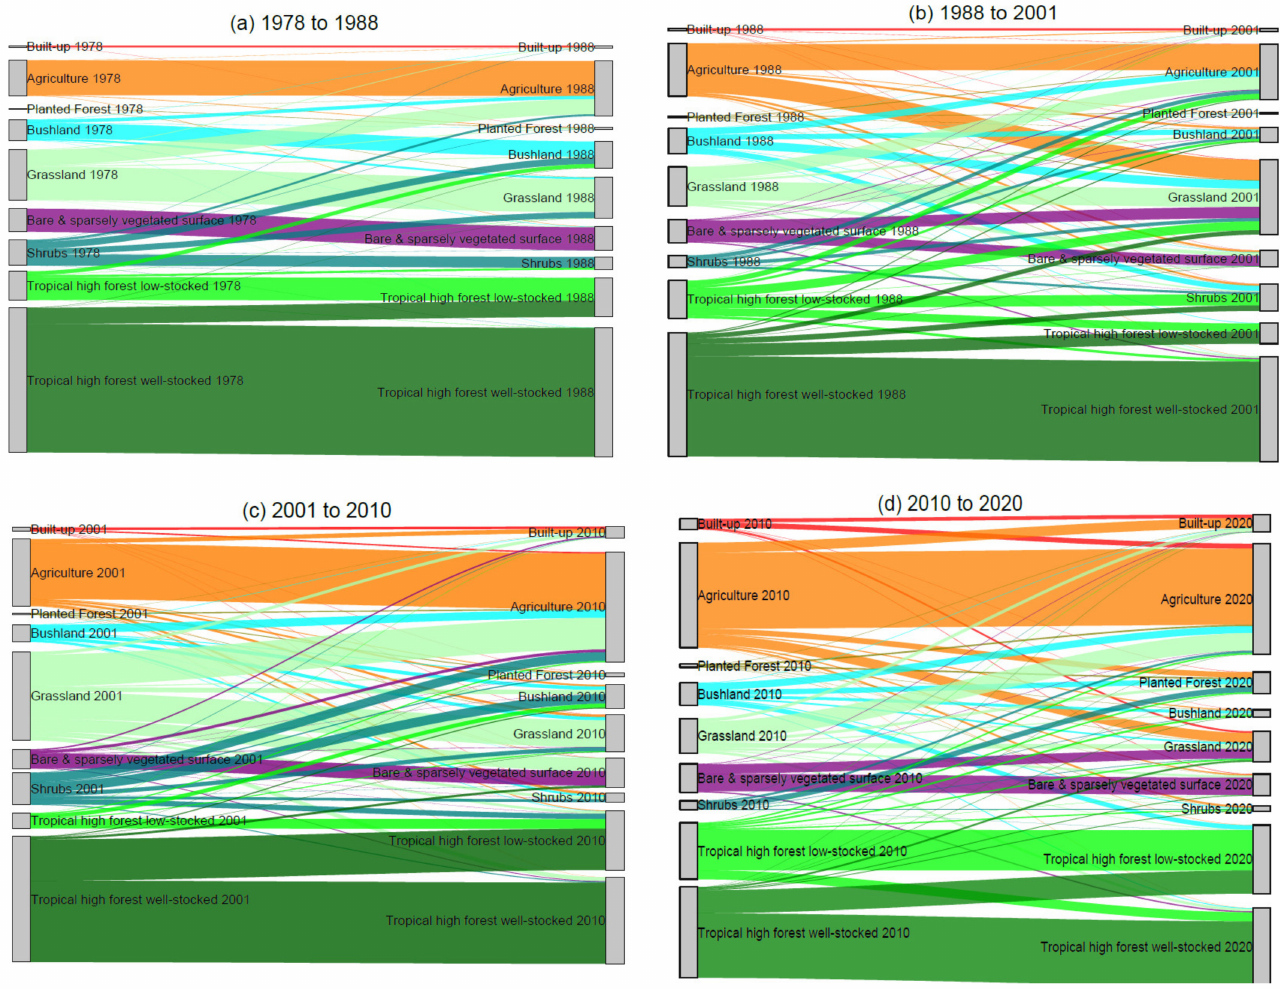
Figure 7. Land cover flows in years of ( a ) 1978–1988, ( b ) 1988–2001, ( c ) 2001–2010, and ( d ) 2010–2020 for the upper Manafwa watershed. The width of the lines represents the land conversion area (km 2 ), the number after the label is the start and end years, and the height of the bars represent the size of the land cover class in the start and end years for each decade considered in this